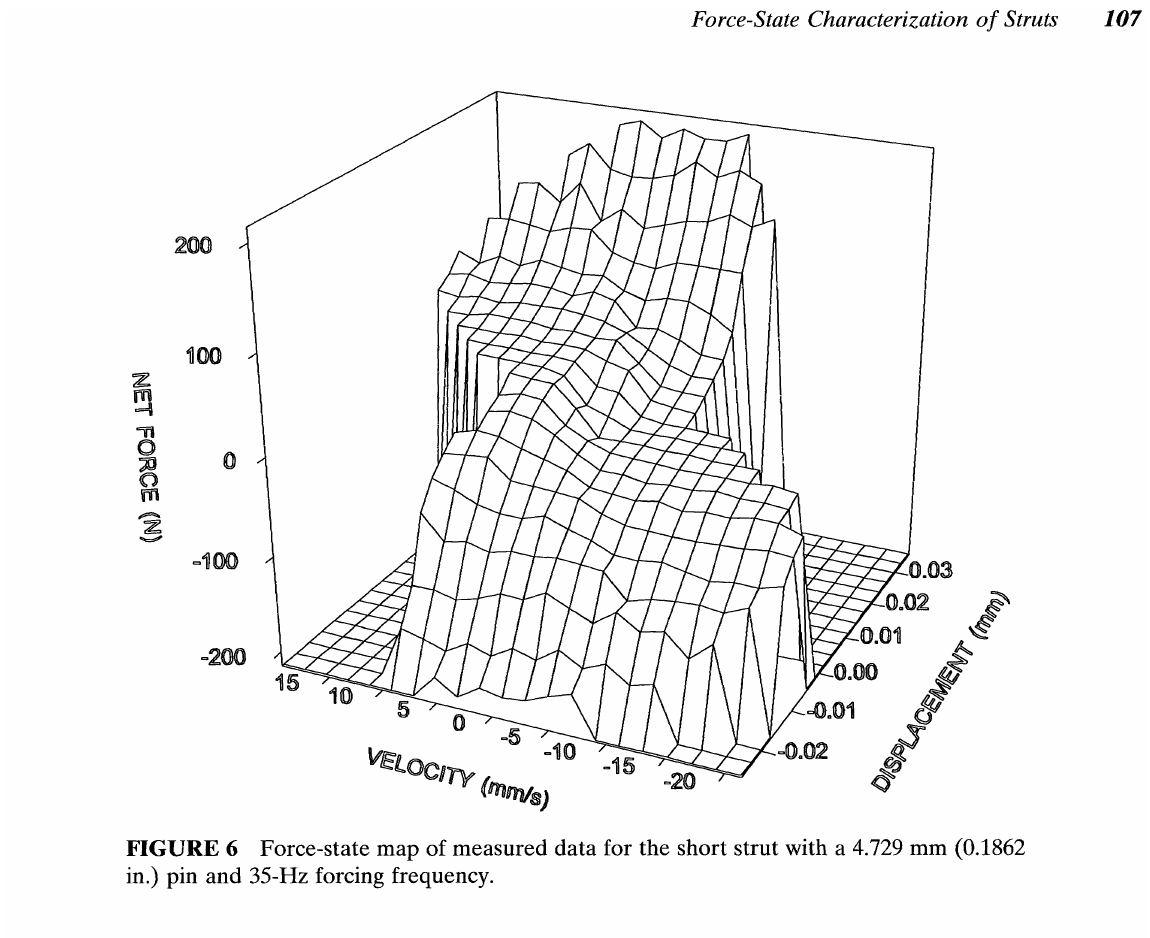
FIGURE 6 Force-state map of measured data for the short strut with a 4.729 mm (0.1862 in.) pin and 35-Hz forcing